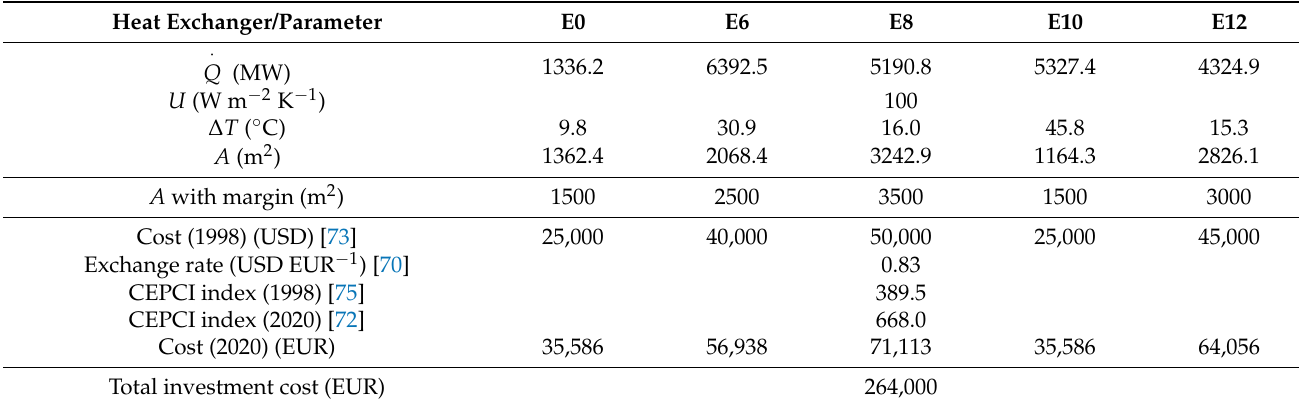
Table 2. Estimation of heat exchangers investment